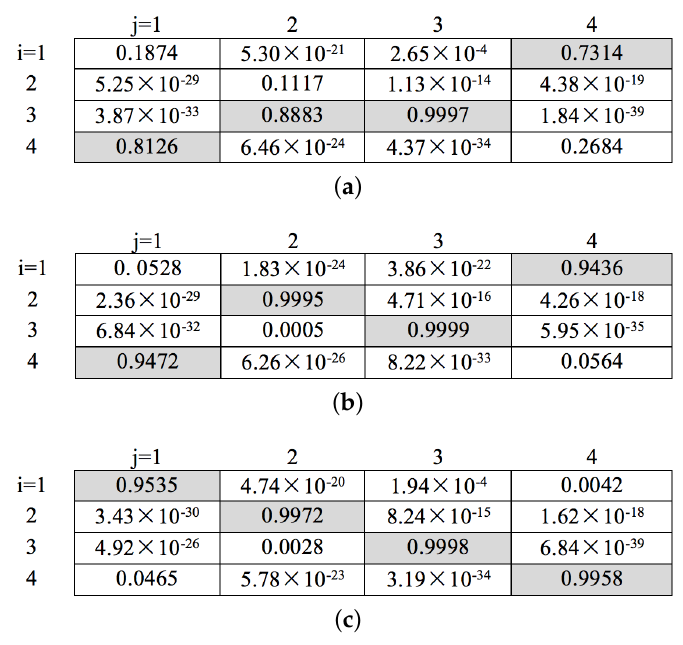
Figure 7. Updated weight matrices at t = 49 on a synthetic image sequence. ( a ) For the GM-PHD tracker; ( b ) for the CPGM-PHD tracker; ( c ) for our tracker.